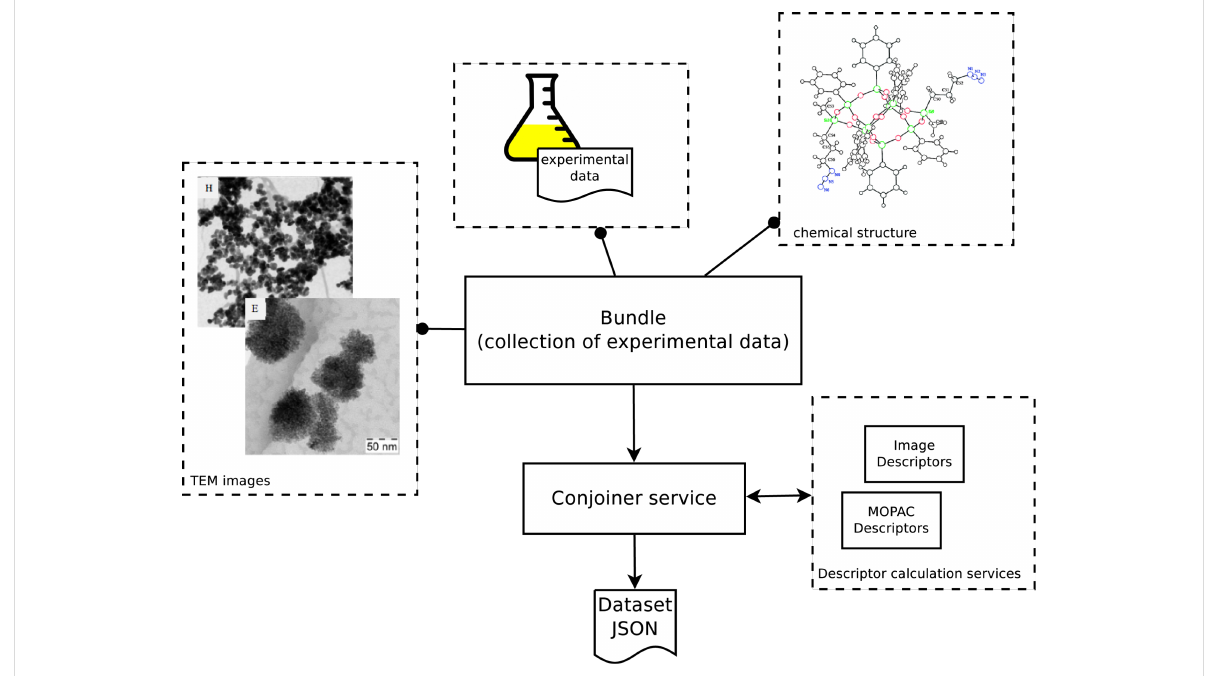
Figure 20: Conjoiner API: modelling-oriented information can be extracted from bundles of experimental data. Data as heterogeneous as chemical structures, raw experimental measurements, spectra and microscopy images can be combined by the conjoiner service to produce a dataset for modelling